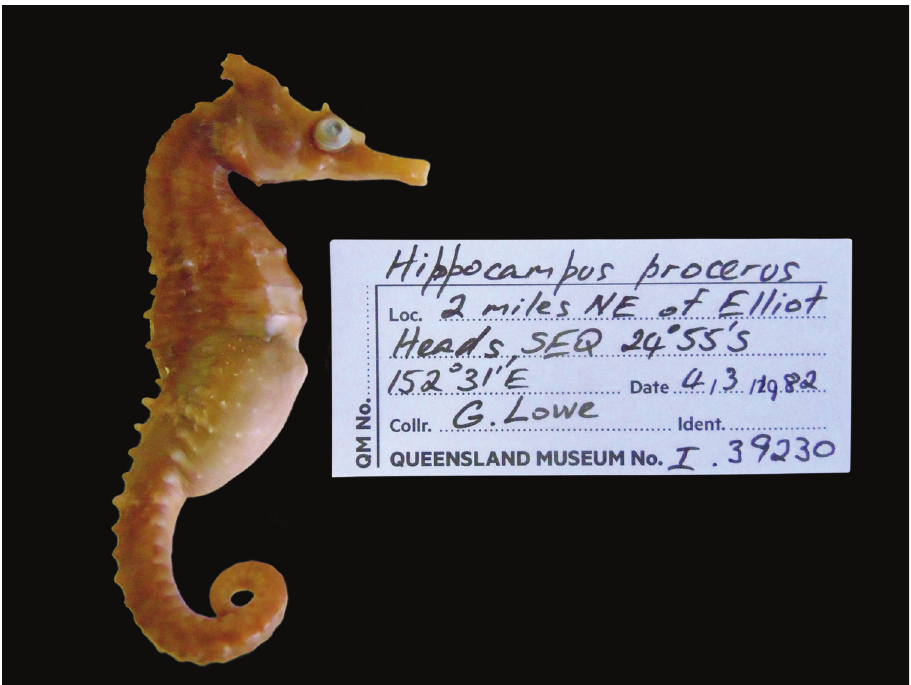
Figure 8. Hippocampus procerus , QM I.39230, adult male, non-type, Elliot Heads, Queensland, Aus- tralia (photograph Jeff Johnson).